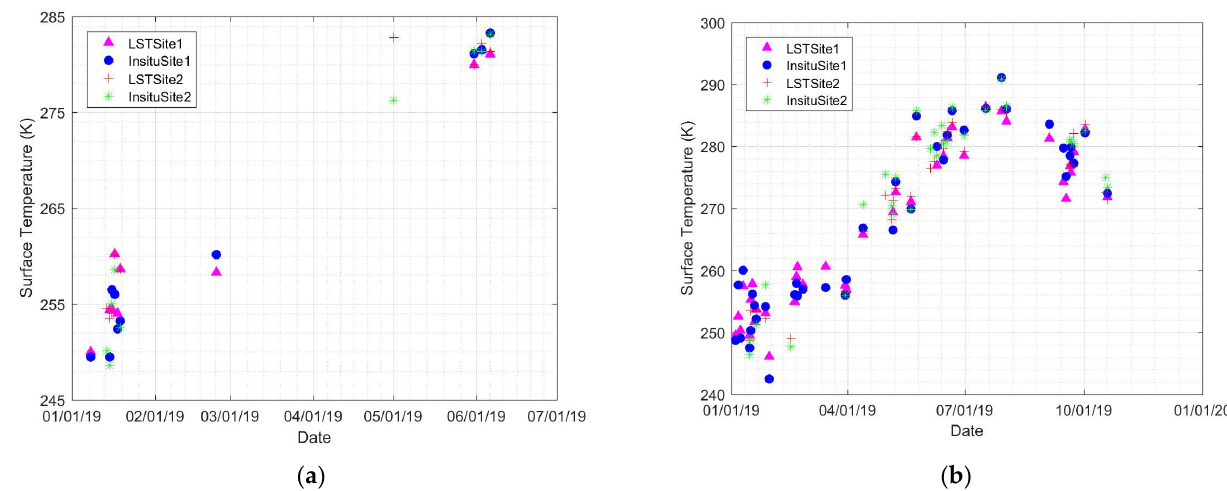
Figure 5. Cloud-free time-series comparison between 30 m LST and in situ LST at site 1 and site 2 from January to October 2019: ( a ) MOD; ( b ) MYD. from January to October 2019: ( a ) MOD; ( b )